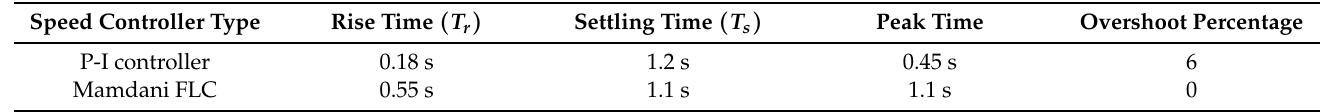
Table 4. Performance comparison between P-I controller and Mamdani fuzzy logic controller (cid:1) speed transition